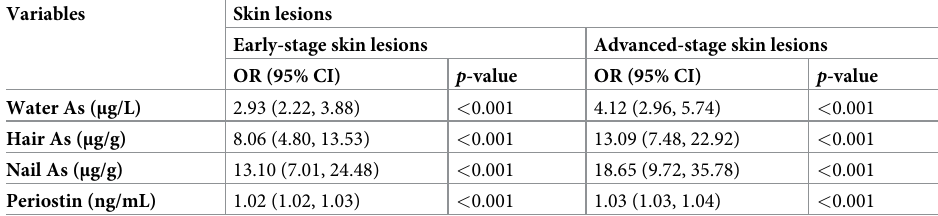
Table 4. Association of arsenic exposure and periostin levels with the risk of different stages of skin lesions.